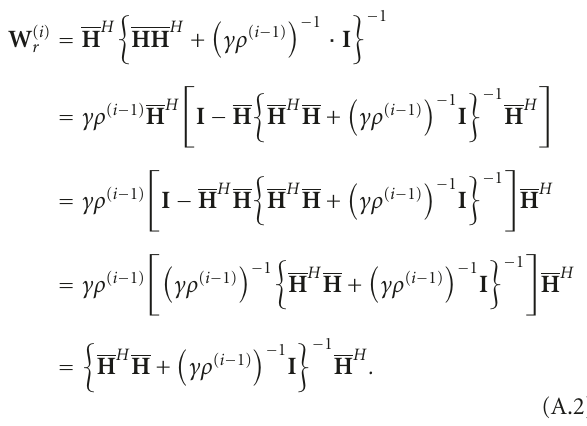
M . Figure 11 plots the PAPR distribution for the di ff erent values of m when M = 4. The channel case 1 and the average transmit E s /N 0 = 8 dB are assumed. The PAPR 10% levels for the conventional scheme and OFDM are also plotted for comparison. It can be seen that the PAPR 10% level increases as m increases. The increase in the PAPR 10% level from the case of m = 0 (initial transmission) is about 0.6 dB, 0.9 dB, and 1.1 dB when m = 1, 2, and 3, respectively. However, the PAPR 10% level of the proposed scheme is still lower than that of OFDM signals irrespective of m